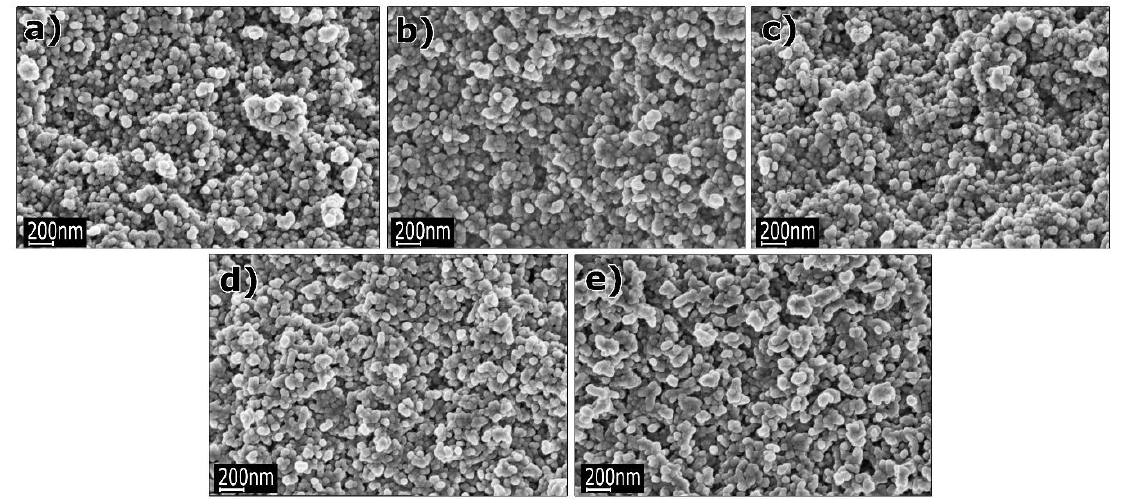
Figure 59. SEM images of ZnO nanopowders in their as-produced (before annealing) state: ( a ) undoped, ( b ) doped with 1 mol% of Co 2 + , ( c ) 5 mol% of Co 2 + , ( d ) 10 mol% of Co 2 + , and ( e ) 15 mol% of Co 2 + ions. Reprinted with permission from [798], Copyright © 2015 Wojnarowicz et al., Article licensed under a CC BY 2.0.